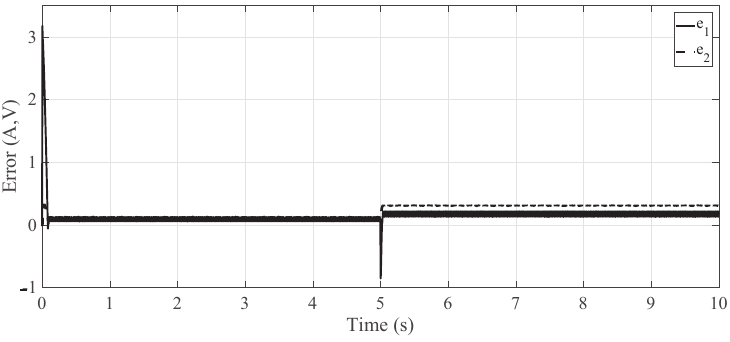
Figure 9. The error of